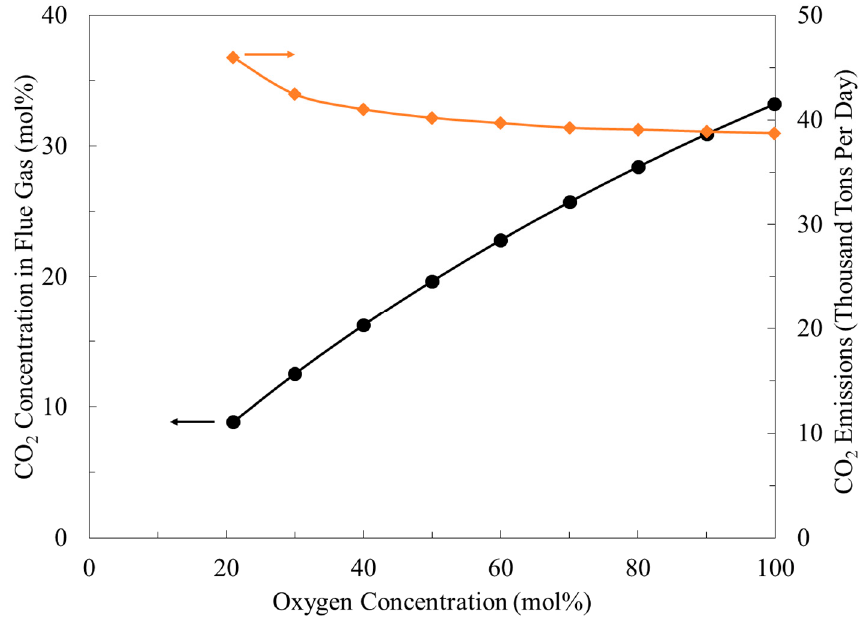
Figure 4. Carbon dioxide concentration in the flue gas and the reduction in emissions due to the use of enriched oxygen.